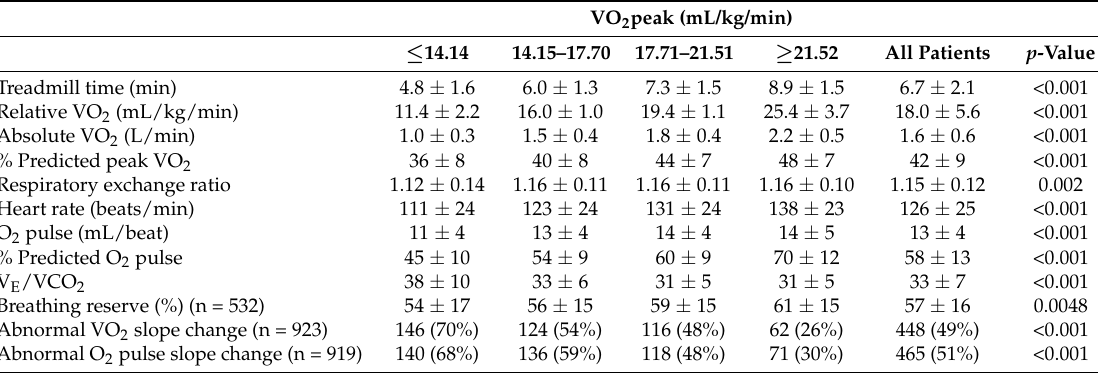
Table 3. Peak cardiopulmonary testing data stratified by peak VO